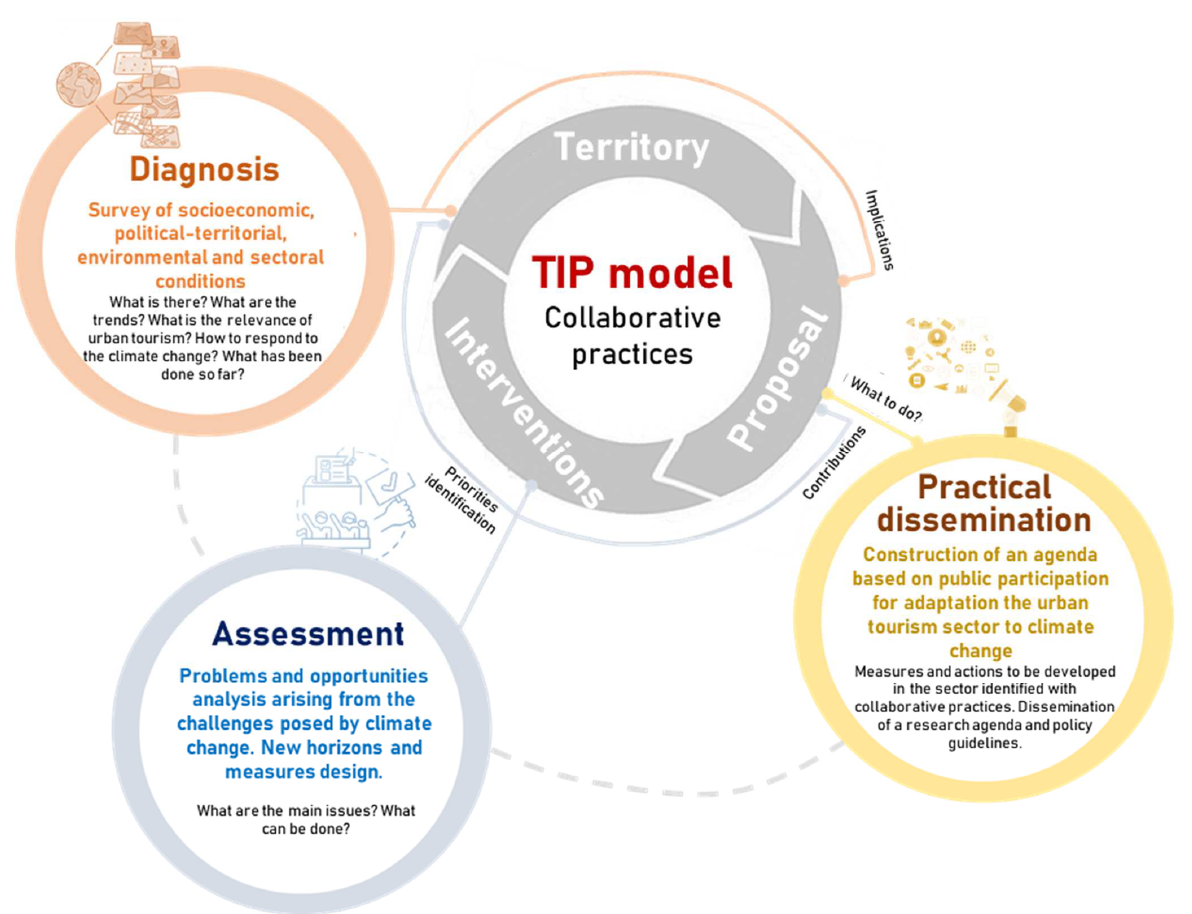
Figure 2. Proposed collaborative research methodology—TIP model (Territory, Intervention, Pro-